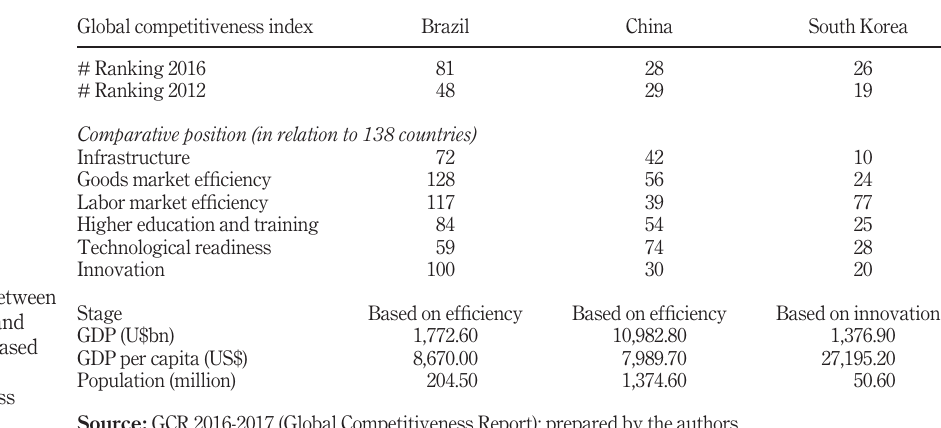
Table II. Comparison between Brazil, China and South Korea based on the global